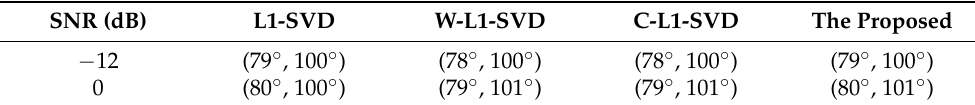
Figure 4. Resolution of four algorithms with two different SNRs: ( a ) SNR = − 12 dB; ( b ) SNR = 0 dB. Table 2. DOA estimates in Figure 4.